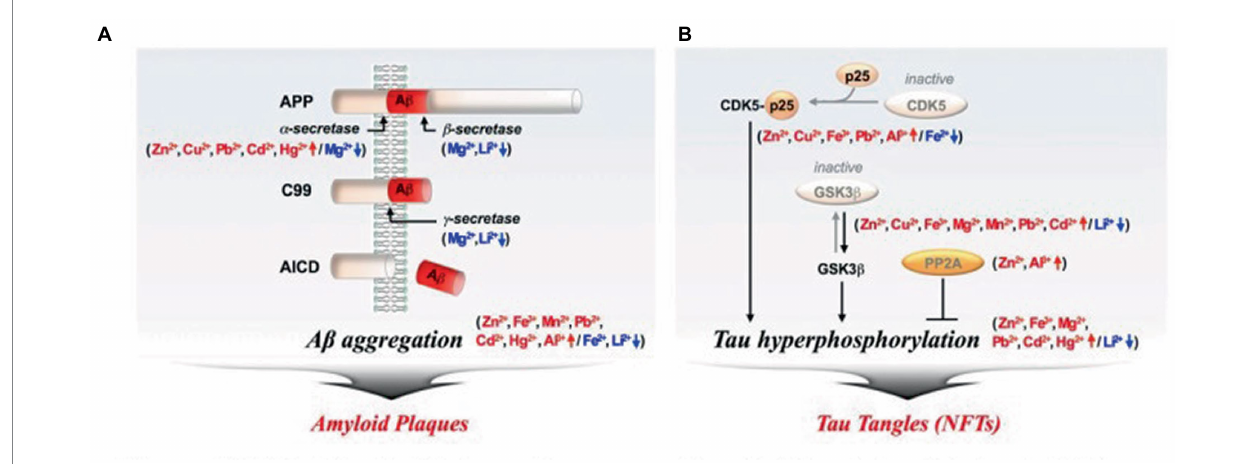
FIGURE 4 Metal ions’ effects on the aggregation of A β and tau. (A) Amyloid Plaques, (B) Tau tangle. A β , amyloid-beta; CDK5, Cyclin-dependent kinase; GSK-3 β , Glycogen synthase kinase-3beta; NFTs, Neurofibrillary tangles; PP2A, protein phosphatase 2A (O’brien and Wong, 2011).